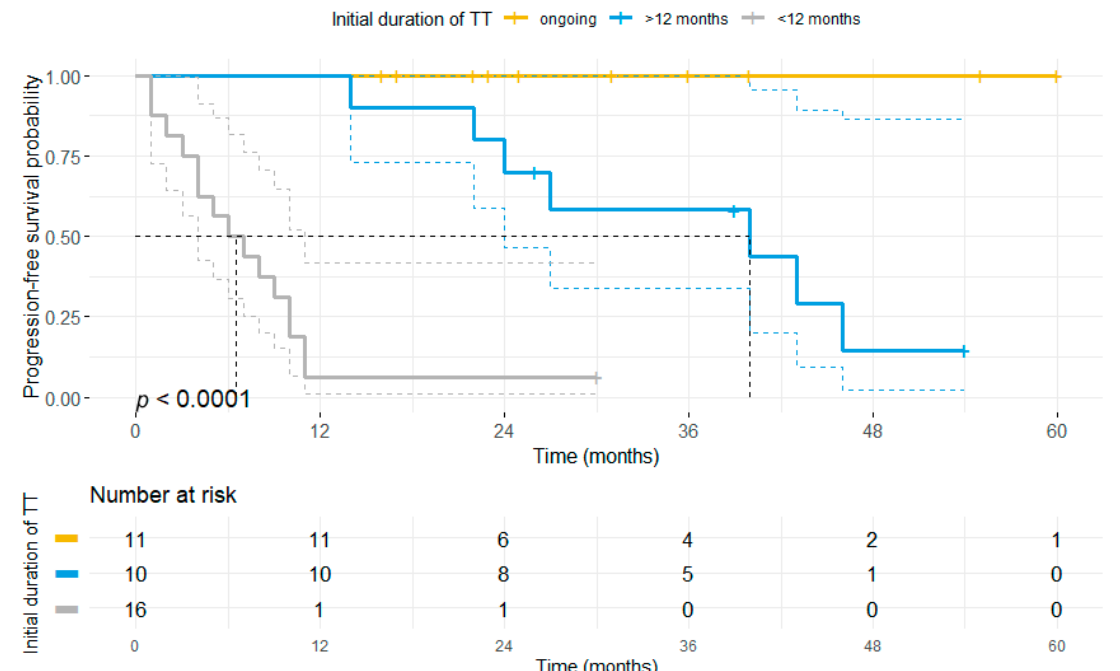
Figure 5. Kaplan ‐ Meier plot illustrating the progression ‐ free survival separated by the reasons for treatment discontinua ‐ tion. Patients who terminated BRAF ± MEKi therapy due to toxicity or disease progression had a significantly shorter PFS (median PFS: 3 months vs. 10 months) compared to patients with ongoing treatment (median PFS not reached, p < 0.0001) or treatment discontinuation due to other reasons (termed as physician’s choice) (median PFS: 40 months, p = 0.013).